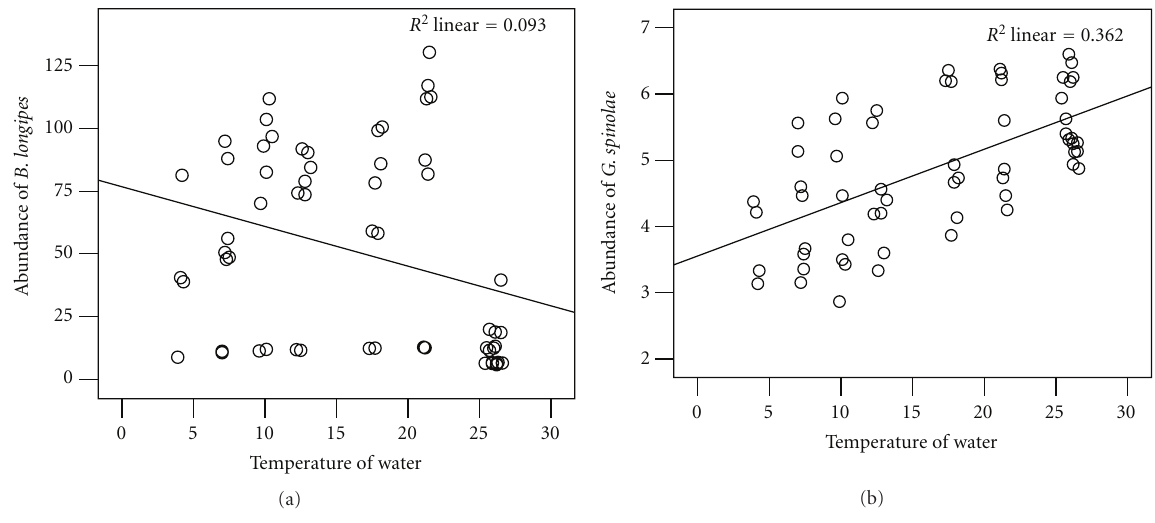
Figure 8: Relation between temperature of water and abundance of (a) Brachydeutera longipes (Hendel) and (b) Gerris spinolae (Lethierry and Severin) as shown by regression analysis.